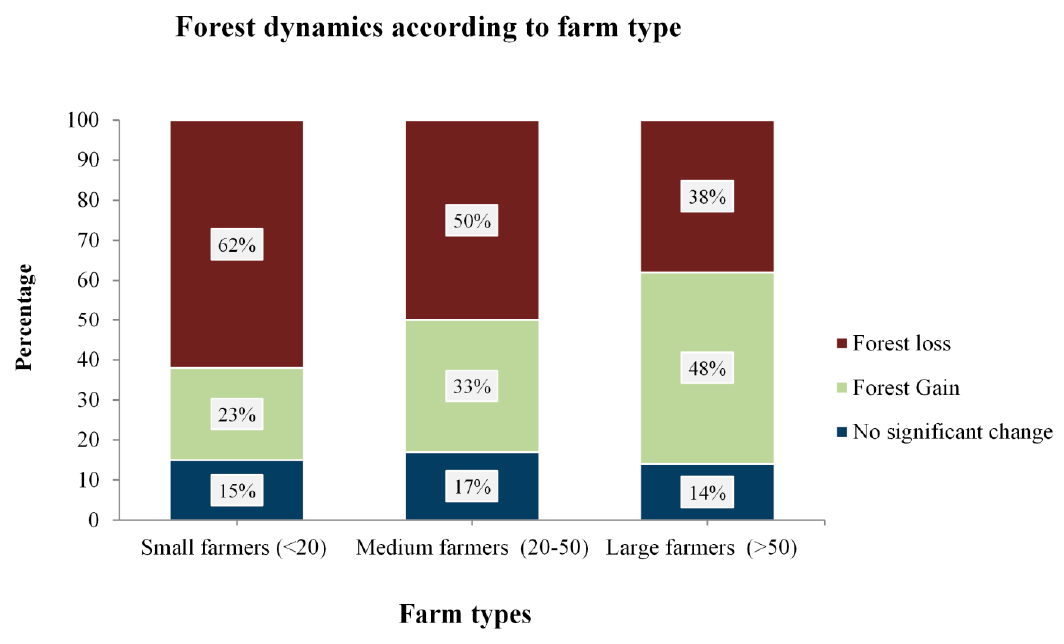
Figure 5. Dynamics of the forest stratified by farm type.